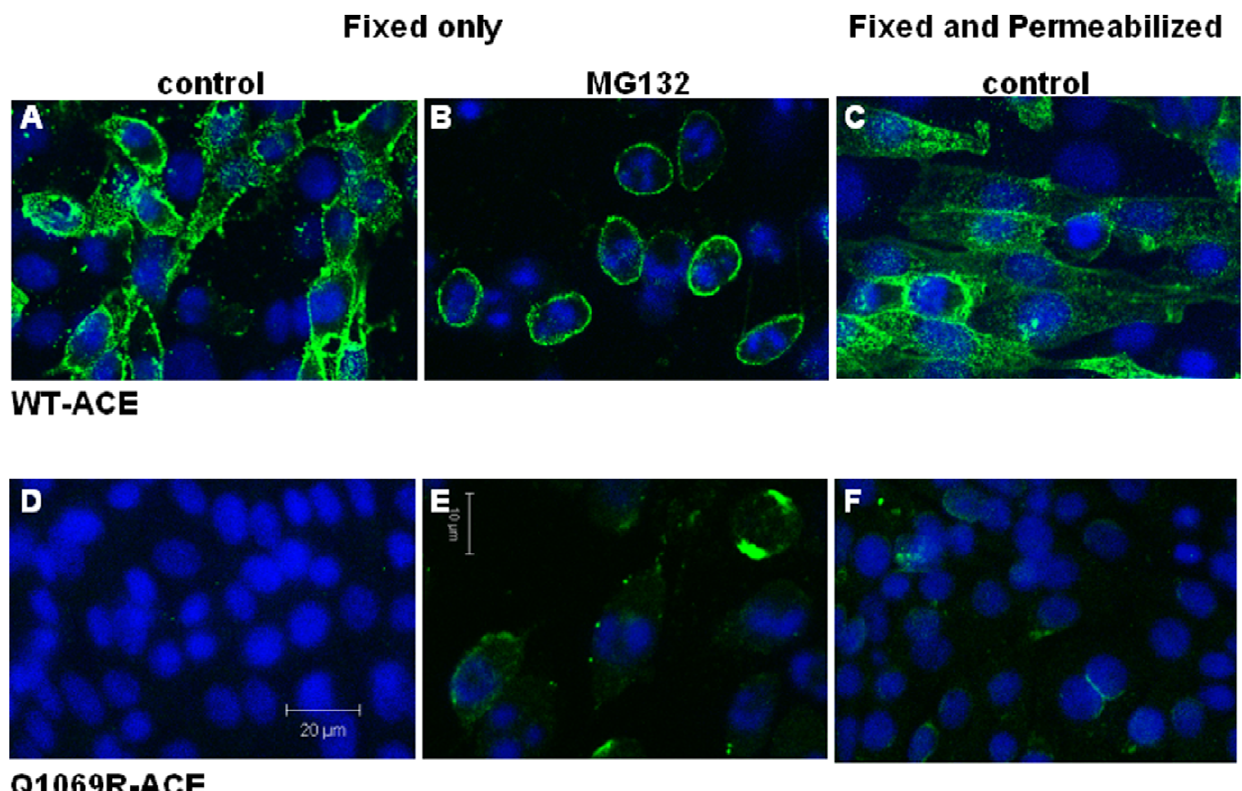
Figure 4. Differential subcellular localization of wild type and mutant ACE. Confocal microscopy was used to determine the localization of WT- vs. Q1069R-ACE mutant expressed in CHO cells following immunostaining with anti-ACE mAb 9B9 and Alexa 488 goat anti-mouse secondary Ab. A-C: WT-ACE expressing cells; D-F: Q1069R-ACE expressing cells. A,B and D,E. Immunostaining of WT and Q1069R ACE in 0.3% paraformaldehye for 15 min at 4C (fixed only). B and E. Treatment with the chemical chaperone sodium butyrate and proteosome inhibitor MG132 for 24 hrs followed by immunostaining with 9B9 mAb. C and F. CHO cells fixed and permeabilized with 3% paraformaldehyde for 15 min at 37C and labeled as above show WT-ACE on the plasma membrane and to a lesser extent in the cytosol and Q1069R-ACE in perinuclear areas.